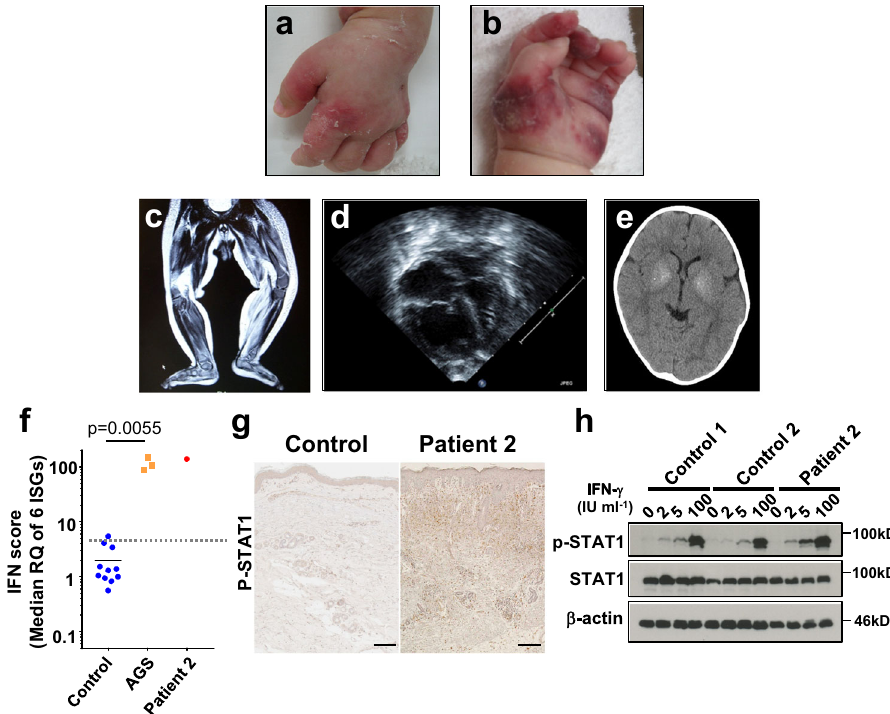
Fig. 1 Clinical fi gures and IFN signature of patients. a, b Pernio-like violaceous rash in patient 1 at 7-month-old ( a ) and patient 2 at 1-month-old ( b ). c – e myositis by leg magnetic resonance imaging ( c ), pulmonary hypertension by echocardiogram( d ), and basal ganglia calci fi cation by head computed